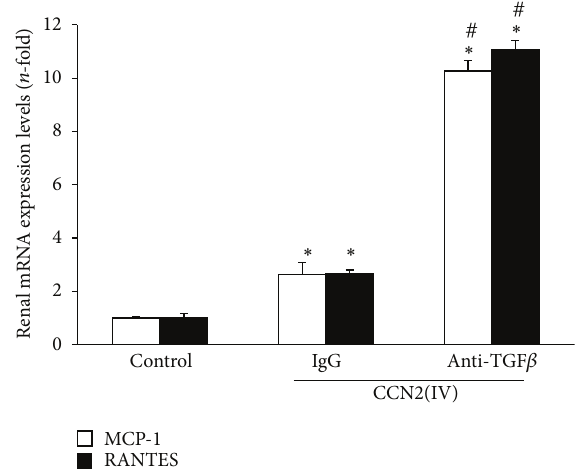
Figure 3: TGF- 𝛽 blockade upregulates CCN2(IV)-induced renal chemokine expression. Kidney gene expression of MCP-1 and RANTES was evaluated by real time PCR. Data are expressed as 𝑛 - fold increase over control as mean ± SEM of 10 animals per group. ∗ 𝑃 < 0.05 versus control. # 𝑃 < 0.05 versus CCN2(IV)-IgG.